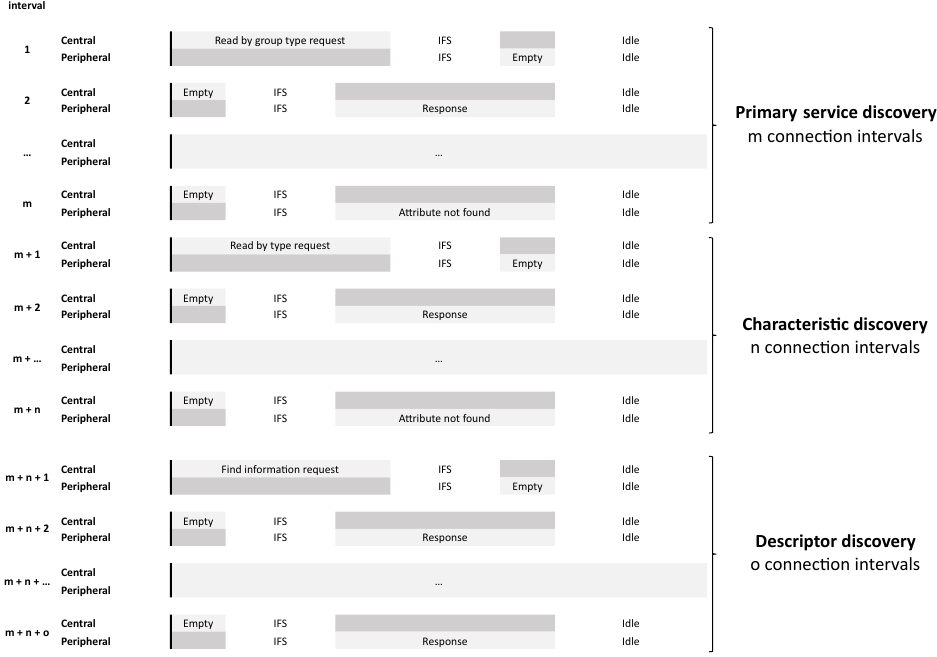
Figure 9. Full service and characteristic discovery